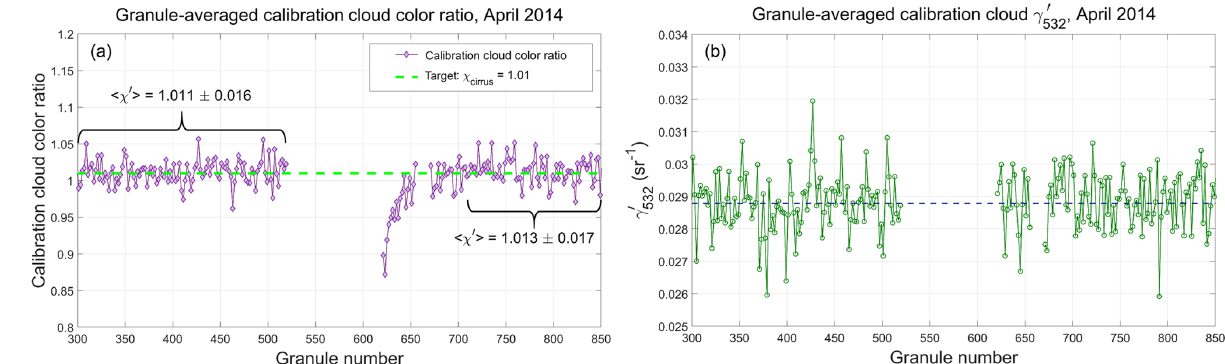
Figure 18. (a) Time series of granule mean χ (cid:48) measured for calibration quality clouds detected during nighttime orbit segments beginning on 11 April 2014 (granule 301), and extending through 30 April 2014 (granule 849). Due to adverse space weather, CALIOP was placed in safe mode, and thus data are missing for over 3 days, from 19 April 2014 at 08:29:42UTC to 22 April 2014 at 16:26:07UTC, spanning granules 521–619. A smaller data gap of just over 8h (from 01:09:36 until 09:38:09UTC on 24 April 2014, spanning granules 657–669) occurs during a satellite drag make-up maneuver. A distinct drop in the magnitude of χ (cid:48) occurs when the lidar is restarted on 22 April. Because there were two instrument shutdowns in relatively rapid succession, full recovery to the pre-outage values takes place over ∼ 72h. (b) Granule mean γ (cid:48) for the same time period. These values remain relatively constant throughout the entire measurement interval, suggesting that the 532nm 532 calibration appropriately compensates for any time-dependent detector gain changes following an instrument